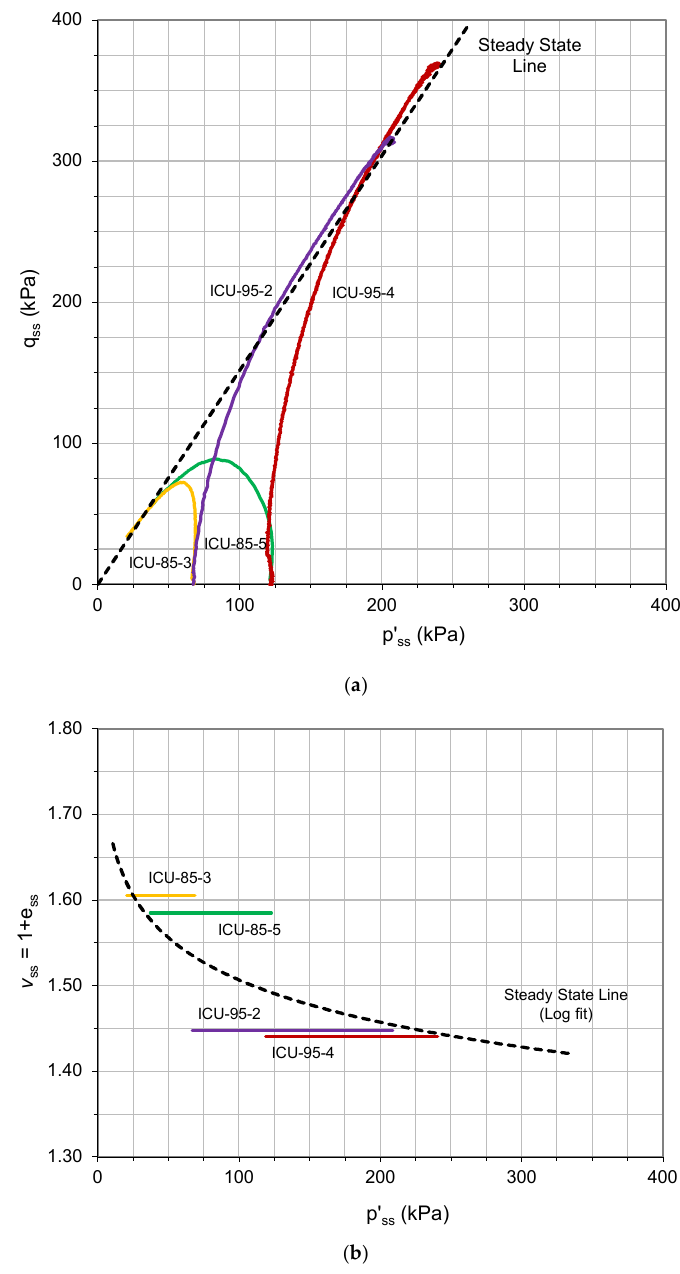
(cid:48) − q ss ; ( b ) p (cid:48) ss